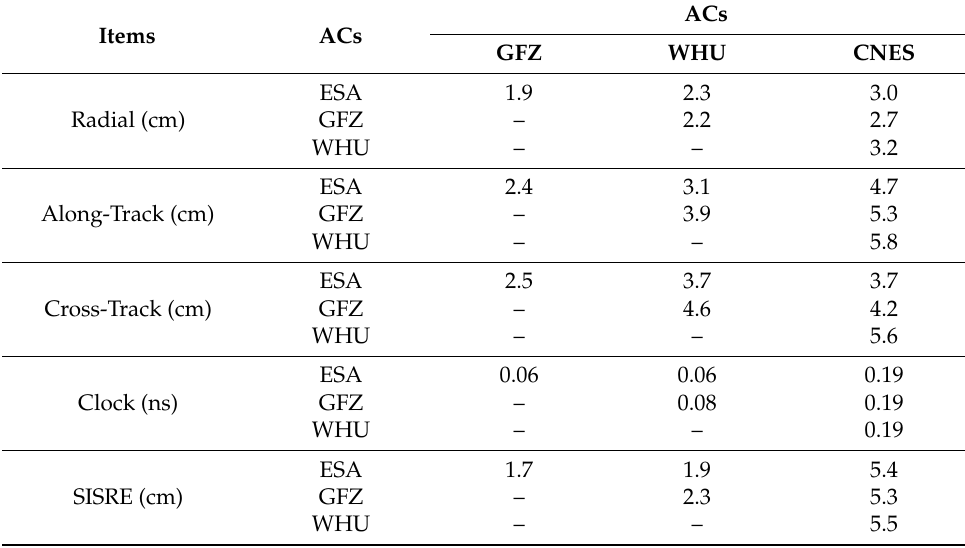
Figure 5. Epoch-wise orbit and clock differences for Galileo satellites between GFZ and WHU precise products on DOY 122 of 2020. Table 4. RMSs of epoch-wise differences of precise satellite orbit and clock corrections among different ACs as well as SISRE statistics for Galileo